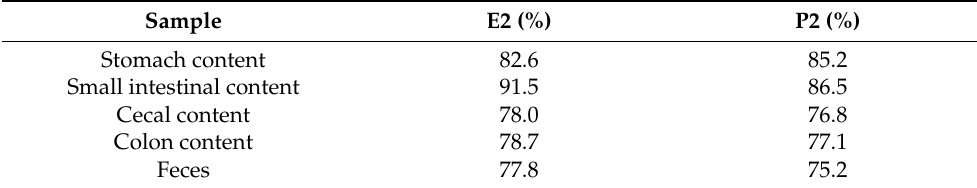
Table 4. Relative group strength of core microbiome families in trial 2.